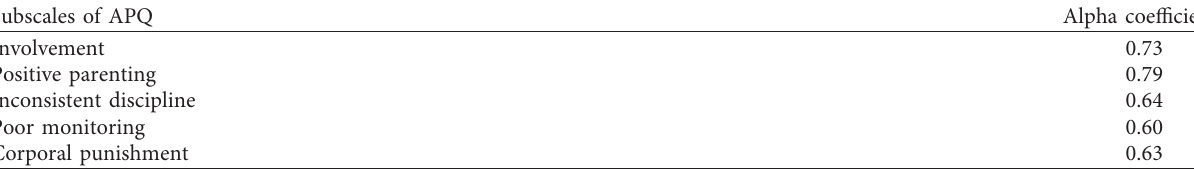
Table 2: Alpha coefficients.